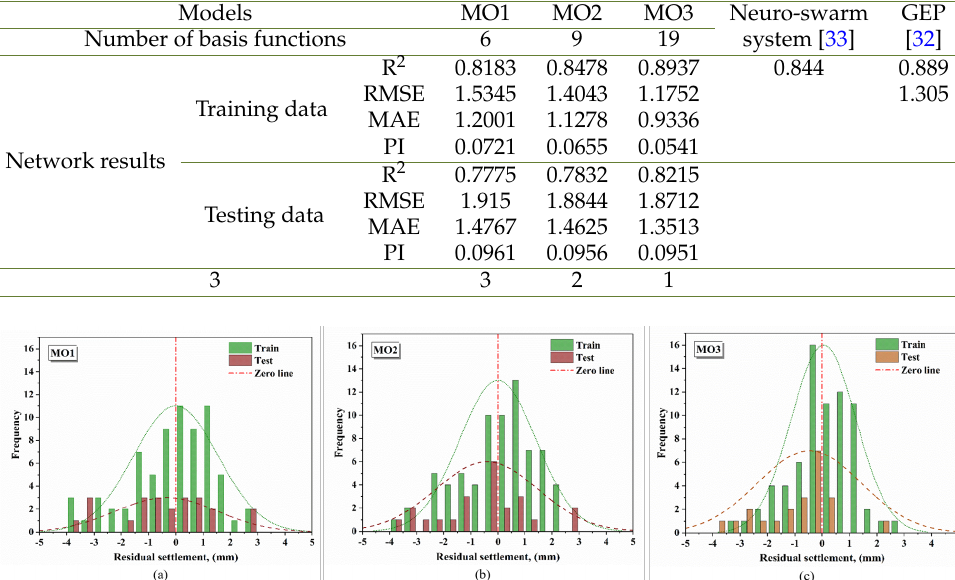
Fig. 8. Histogram of comparison between model’s residual of settlement (Predicted-Measured) using training and testing data; a) MO1 Eq. (11); b) MO2 Eq. (12); c) MO3 Eq.